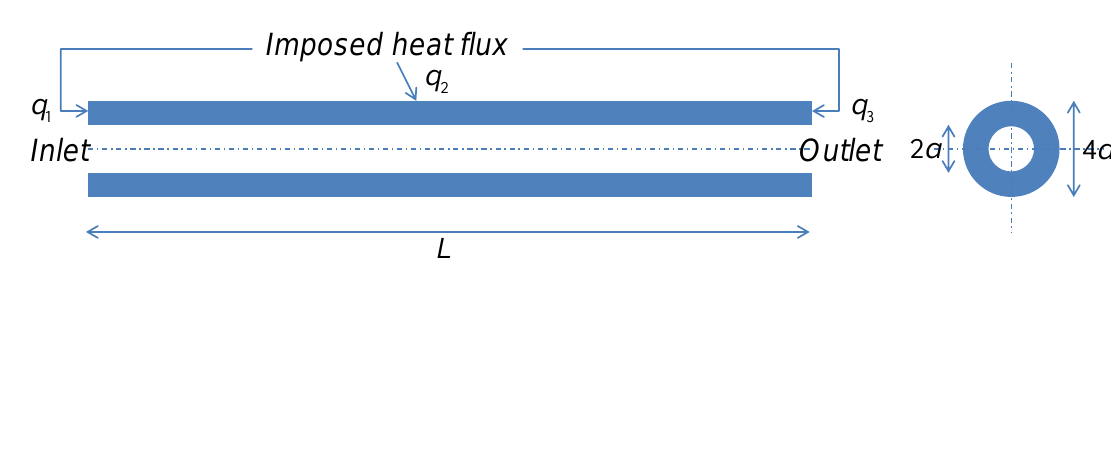
Figure 5. Geometry of the pipe flow